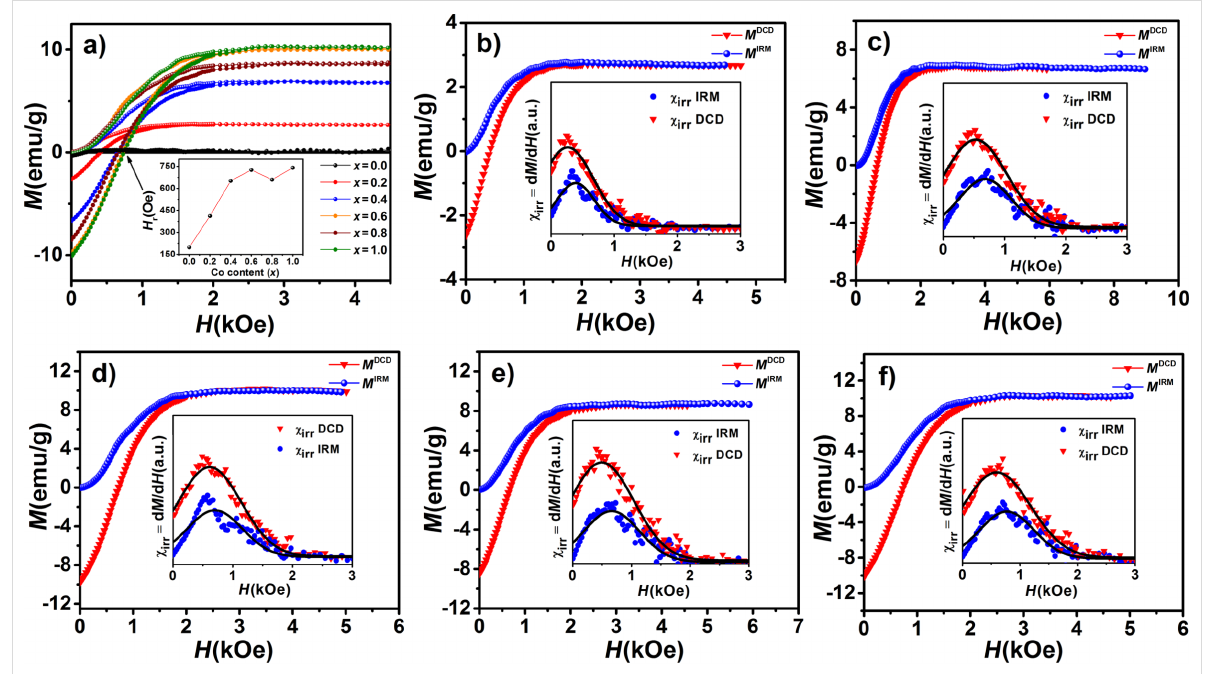
Figure 11: IRM and DCD magnetization curves of (a) all Co x Fe 3 − x O 4 samples and separately for (b) x = 0.2, (c) x = 0.4, (d) x = 0.6, (e) x = 0.8 and (f) x = 1. The inset in (a) shows the reverse field as a function of x . The other insets show the irreversible susceptibility χ irr obtained from M IRM and M DCD